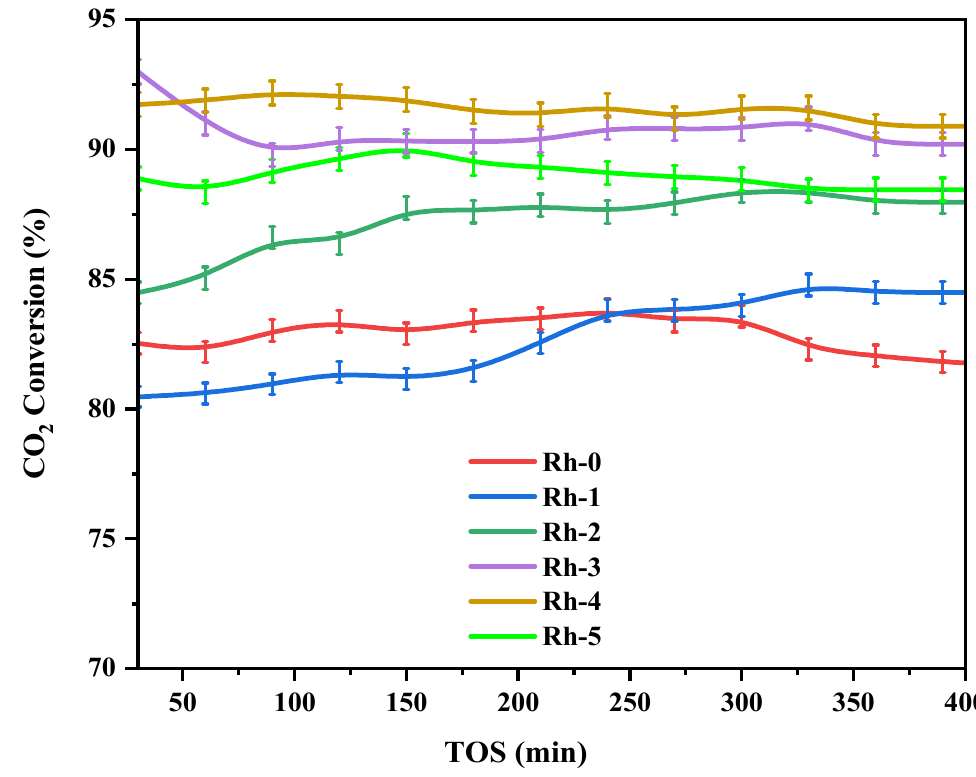
Figure 6. CO 2 conversion versus TOS for the Ni-Rh-x (x = 0, 1, 2, 3, 4, 5 wt.%) catalysts operated at 800 °C.